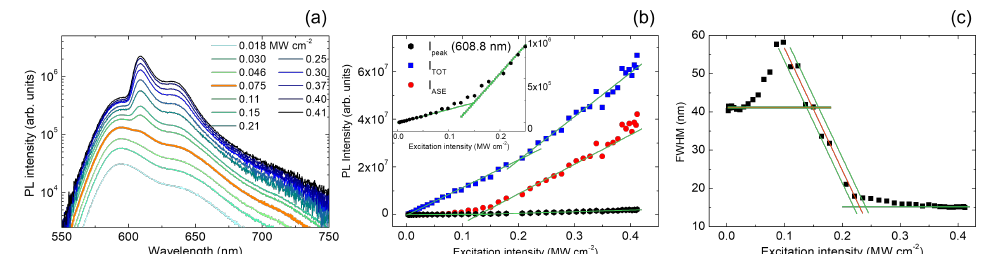
Figure 3. ( a ) Excitation intensity dependence for a selection of the PL spectra of the SRhB sample. The thicker orange line evidences the first spectrum in which the lineshape is modified by the ASE presence. ( b ) Excitation intensity dependence of the total integrated intensity (I TOT , black dots), ASE integrated intensity (I ASE , red dots), and of the intensity at the ASE band peak wavelength (I peak , blue dots). Inset: zoom of the I peak plot at the slope change. The green lines are the best-fit curves. ( c ) Excitation intensity dependence of the PL spectra FWHM. The red lines are the best-fit curves and the green lines are the limits of the uncertainty